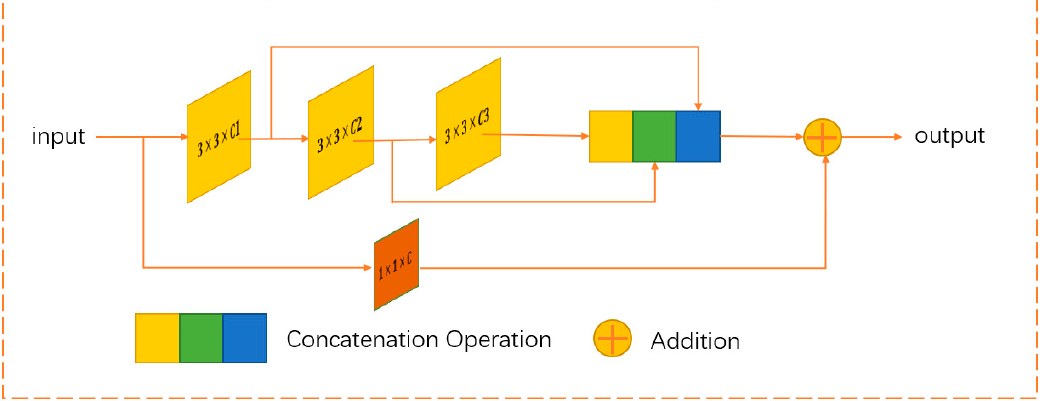
Figure 2. Multi-Res block.